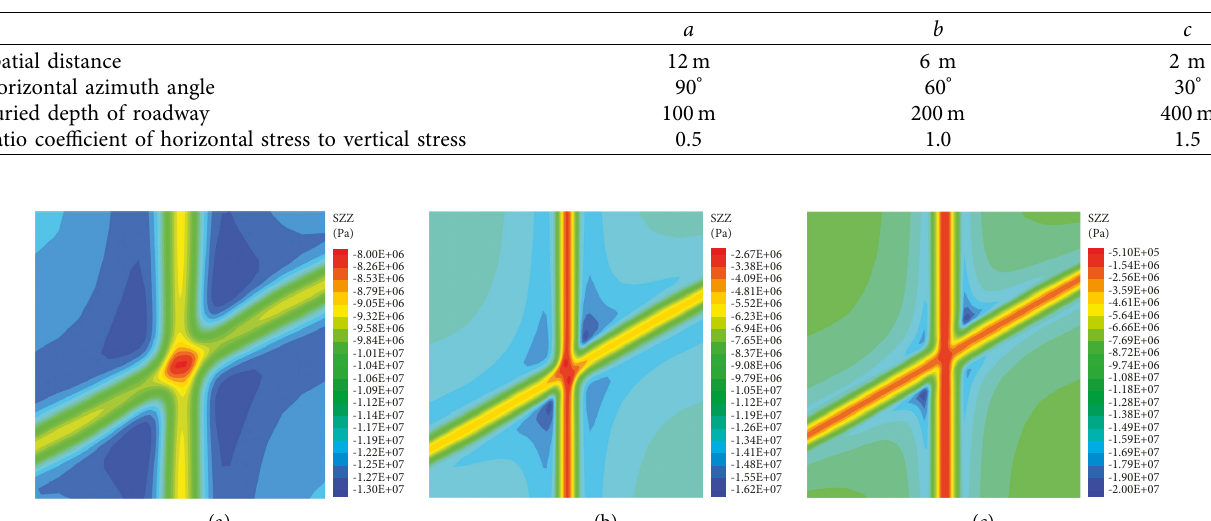
Table 2: Simulation scheme setting